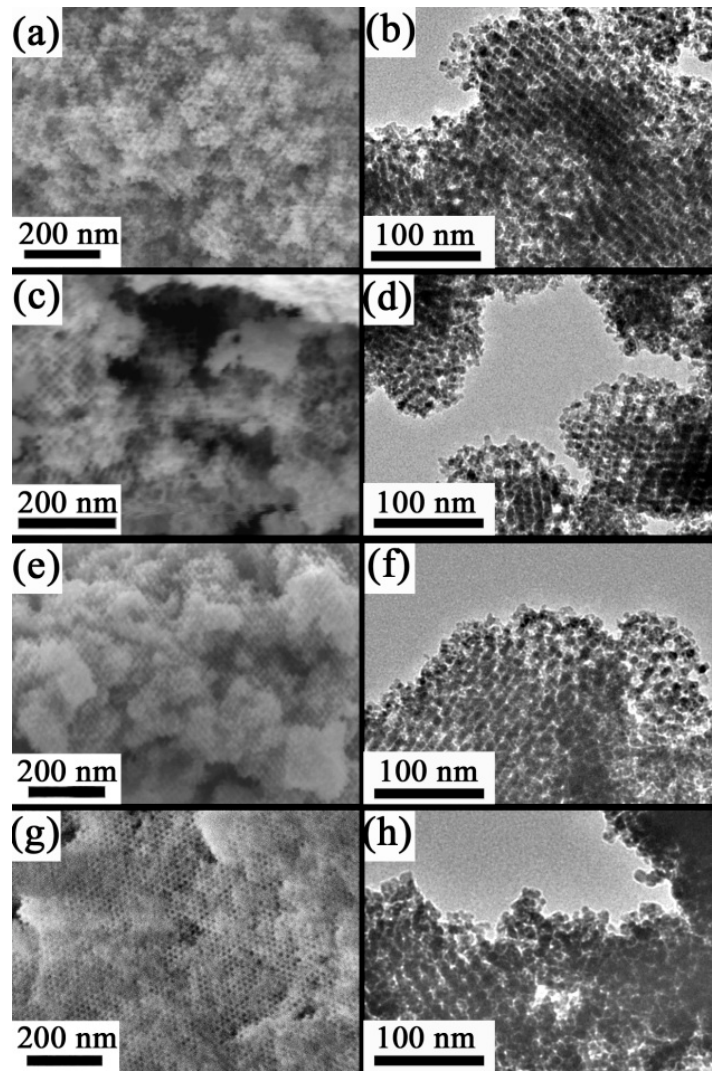
Figure 1. Morphology of Cu-doped SnO 2 powders after KIT–6 silica removal. Panels ( a , c , e , g ) are the scanning electron microscopy (SEM) images of the powders obtained from different [Cu(II)]:[Sn(II)] molar ratios (0:100, 5:95, 15:85, and 20:80, respectively). Panels ( b , d , f , h ) are the corresponding transmission electron microscopy (TEM) images.